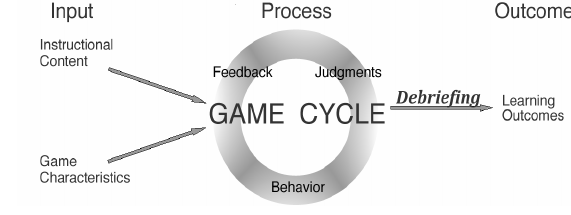
Figure 1. Game-based learning model